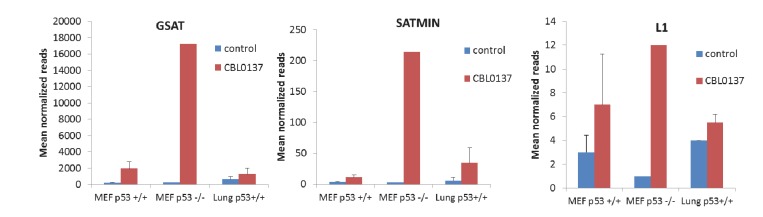
Abundance of transcripts corresponding to major (GSAT) or minor (SATMIN) satellites or LINE1 per millions of reads of RNA-seq of total RNA from MEF cells from Trp53 wild type (p53+/+) or Trp53-null (p53-/-) mice or lung tissue of Trp53 wild-type mice treated with either 1 μM or 60 mg/kg of CBL0137 for 24 hr.